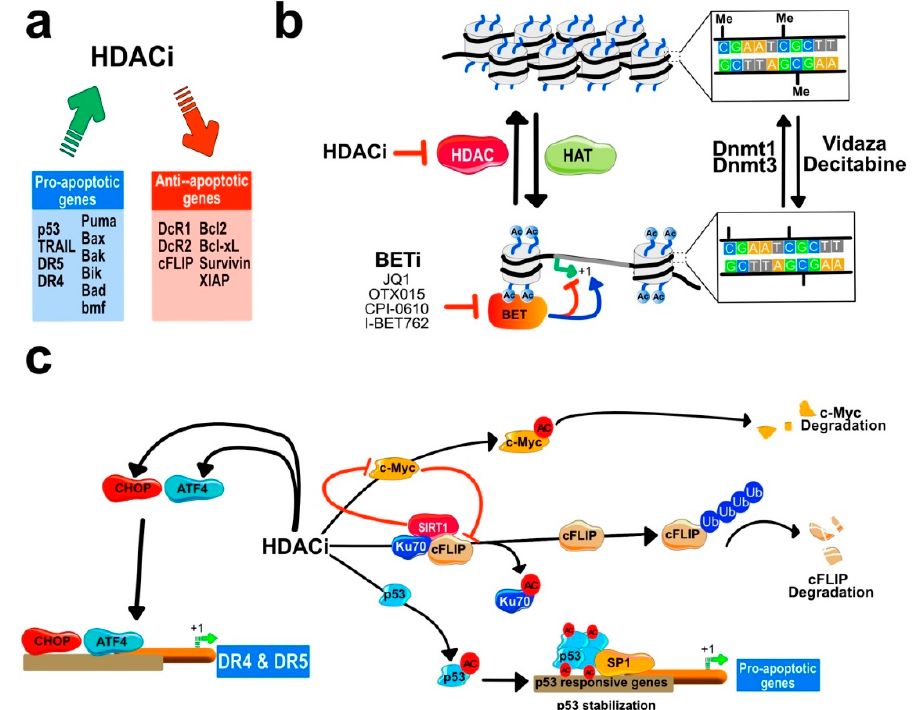
Figure 11. Schematic representation of epigenetic events regulating TRAIL-induced apoptosis. ( a ) Main genes regulated by HDACi, either positively or negatively. ( b ) Illustration of the main epigenetic events affecting chromatin compaction and inhibitors that stimulate chromatin relaxation-based histone acetylation. Bromo-and extra terminal domains (BET) specifically bind to acetylated histones, regulating either positively or negatively genes in the neighborhood. Methylation of CpG island by DNA methylases also contribute to gene silencing. ( c ) HDACi can also regulate gene expression and increase sensitivity to TRAIL-induced apoptosis through acetylation of non-histone proteins. Acetylation of c-Myc induce its degradation whereas acetylation of Ku70 and p53, on the other hand, lead to enhanced TRAIL-induced cell death due to degradation of c-FLIP and upregulation of pro-apoptotic gene expression. HDACi can also induce regulation of TRAIL death receptors (DR4 & DR5) gene expression through the ER-stress sensors ATF4 and CHOP, see text.